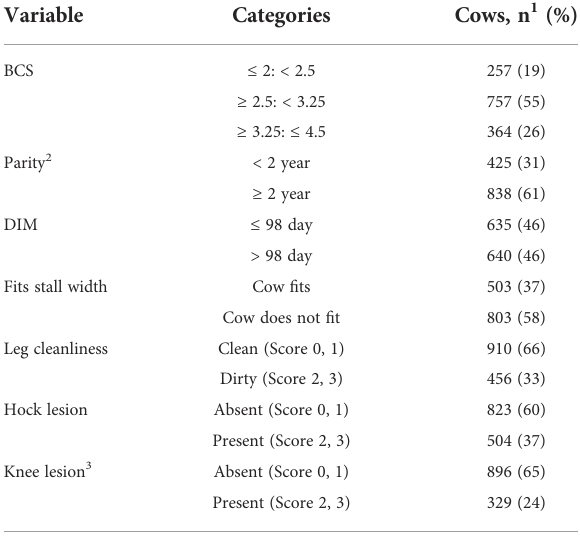
TABLE 1 Number of cows per measurement from 1,378 cows on 36 dairy farms with